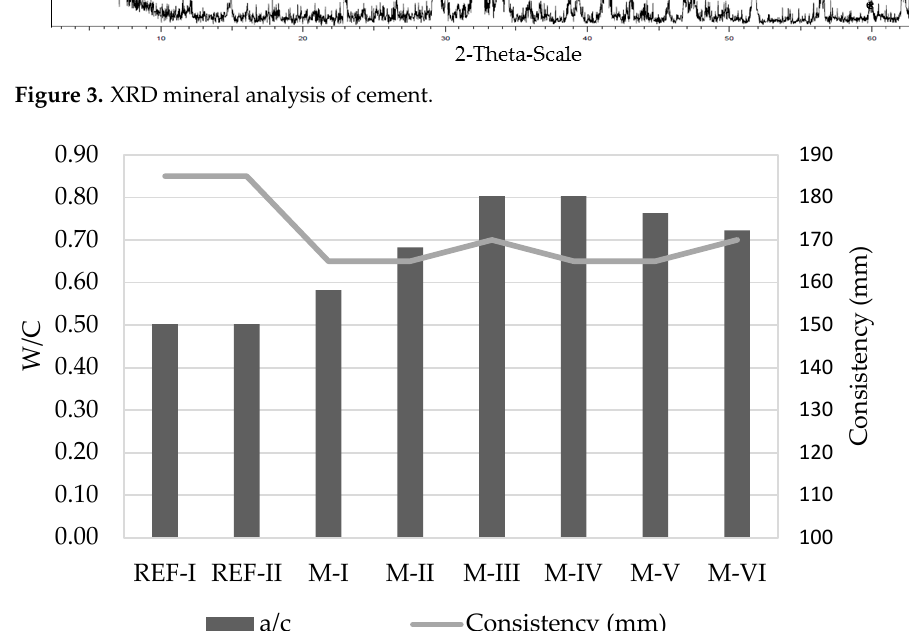
Figure 3. XRD mineral analysis of cement.